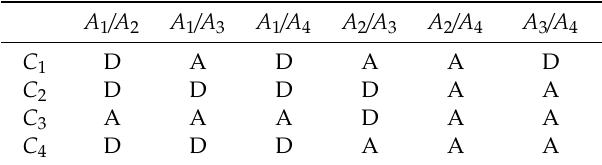
Table 4. Advantage–disadvantage matrix under each attribute C j between two judgment